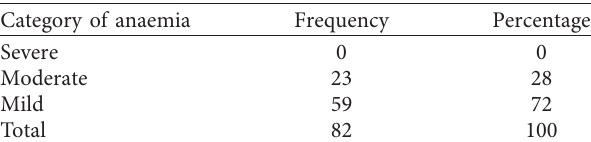
Figure 1: Overall prevalence of anaemia when less than 30% was used as a cutoff. Table 3: Distribution of anaemia in pregnancy according to